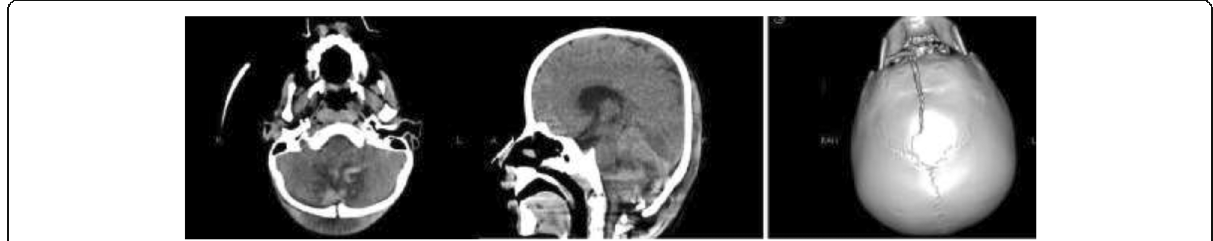
Fig. 1 Midline cerebellar contusion in axial and sagittal sections with orbital fracture. Consent has been taken from the patient ’ s father to attach this image with case